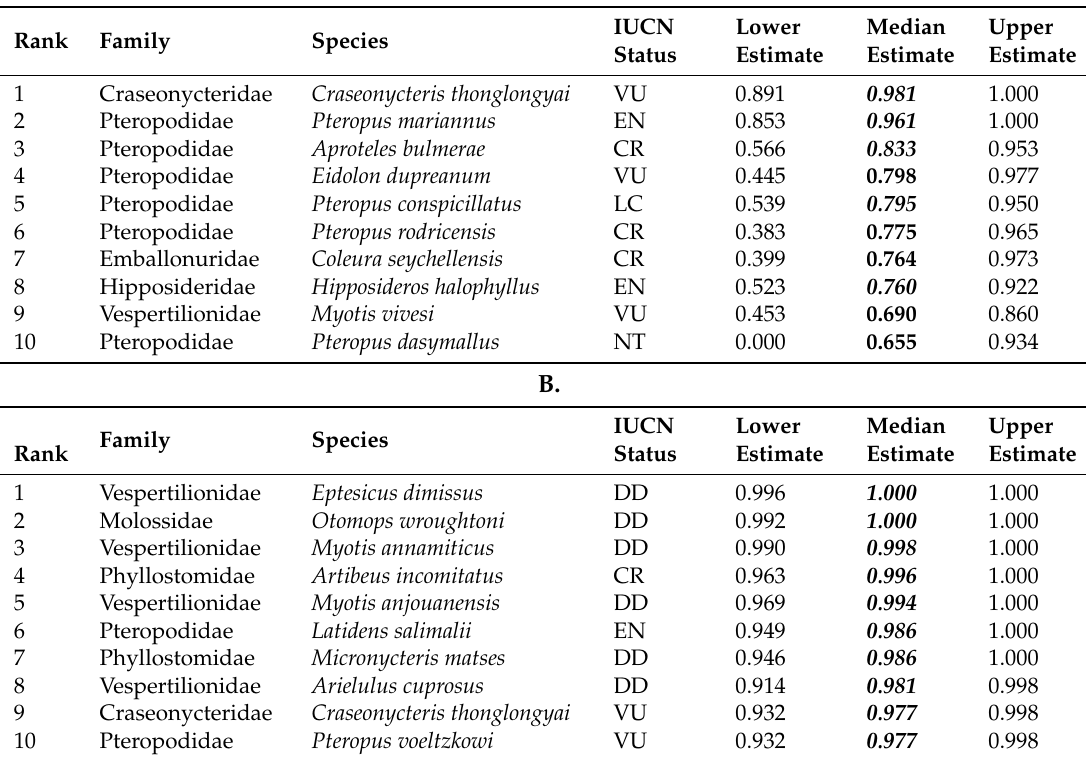
Table 4. Information for the top ten species at risk of extinction according to simulations. 95% prediction intervals are shown. The median estimate is bold if it is above 0.5 (i.e., a threatened prediction), and bold and italic if the lower estimate is above 0.5. A. Predictor-rich model. B. Taxon-rich model.